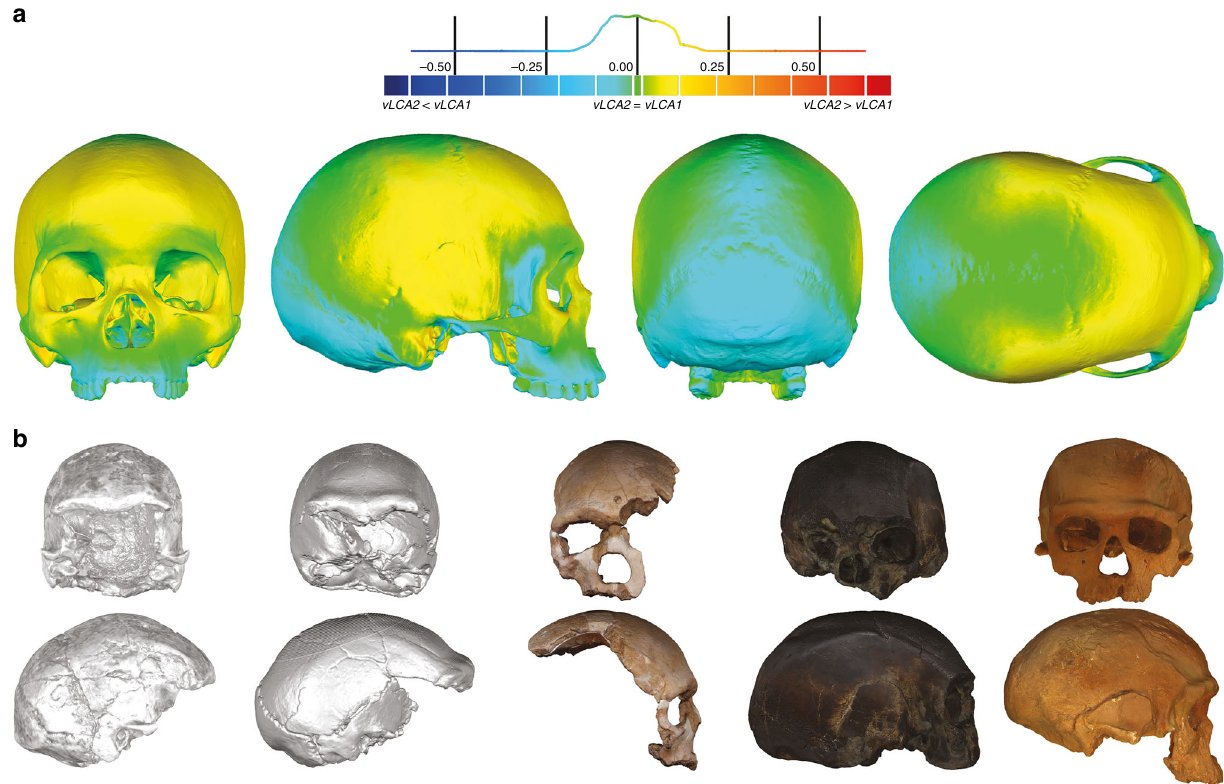
Fig. 3 Morphology of the vLCAs and of the LMP fossils. a Norma frontalis , lateralis , verticalis , occipitalis of vLCA1 when compared to vLCA2 through a surface deviation analysis. The histogram indicates the distribution of the deviation in mm between each vertex of the 3d models. b From left to right, norma frontalis and lateralis of Omo II, LH18, Florisbad, KNM-ES 11693 (the norma lateralis view is mirrored), and Irhoud 1. Source data are provided as a Source Data fi